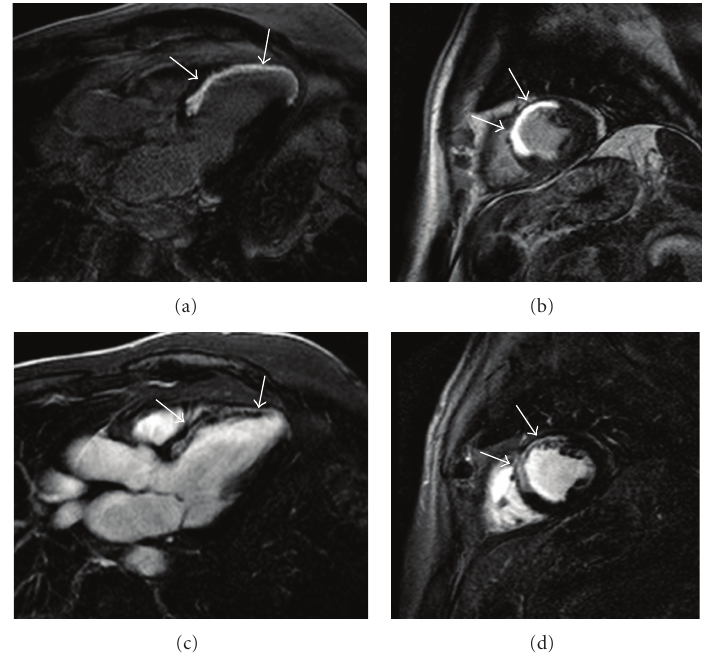
Figure 1: Transmural LGE detected with the extracellular CAs in long-axis and short-axis view (a and b) compared with MS-325LGE (c and d). Both CA show a clear contrast between the enhanced area and the surrounding normal myocardium. However, blood pool signal is brighter for MS-325 related to higher relaxivity and vascular retention.